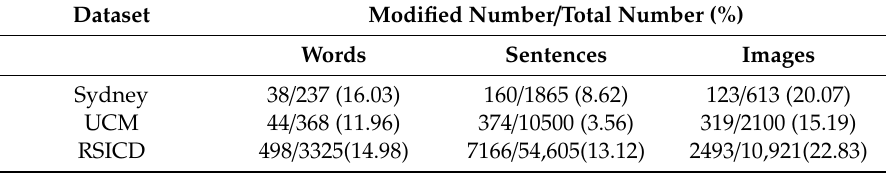
Table 1. The number of modifications for the three datasets. For example, we modify 38 words for the Sydney dataset, and this dataset has a total of 237 words, so the percentage we modified is 38 / 237 =